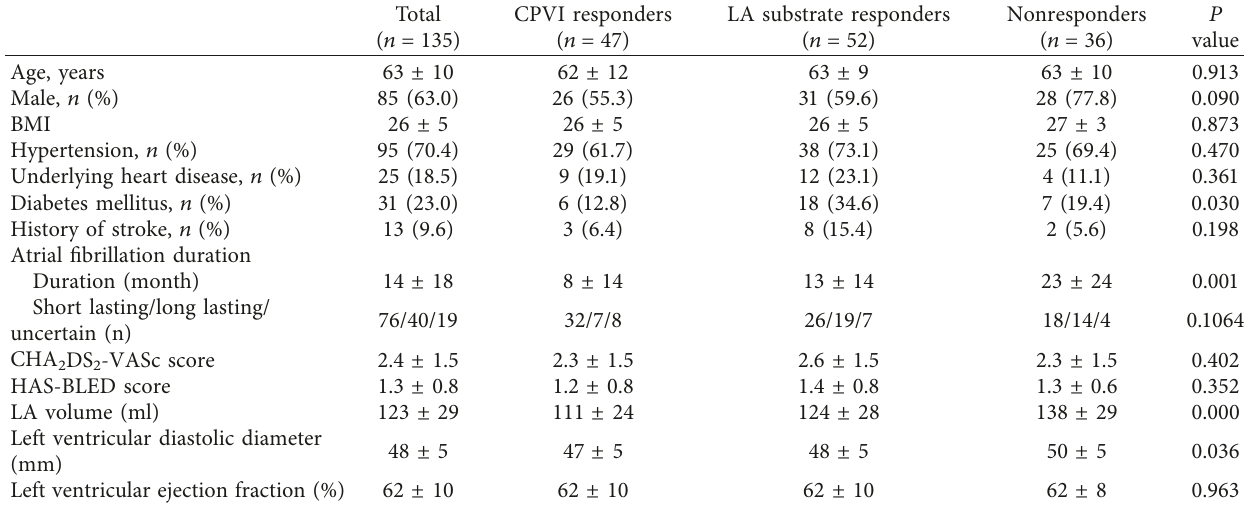
Table 1: Patient